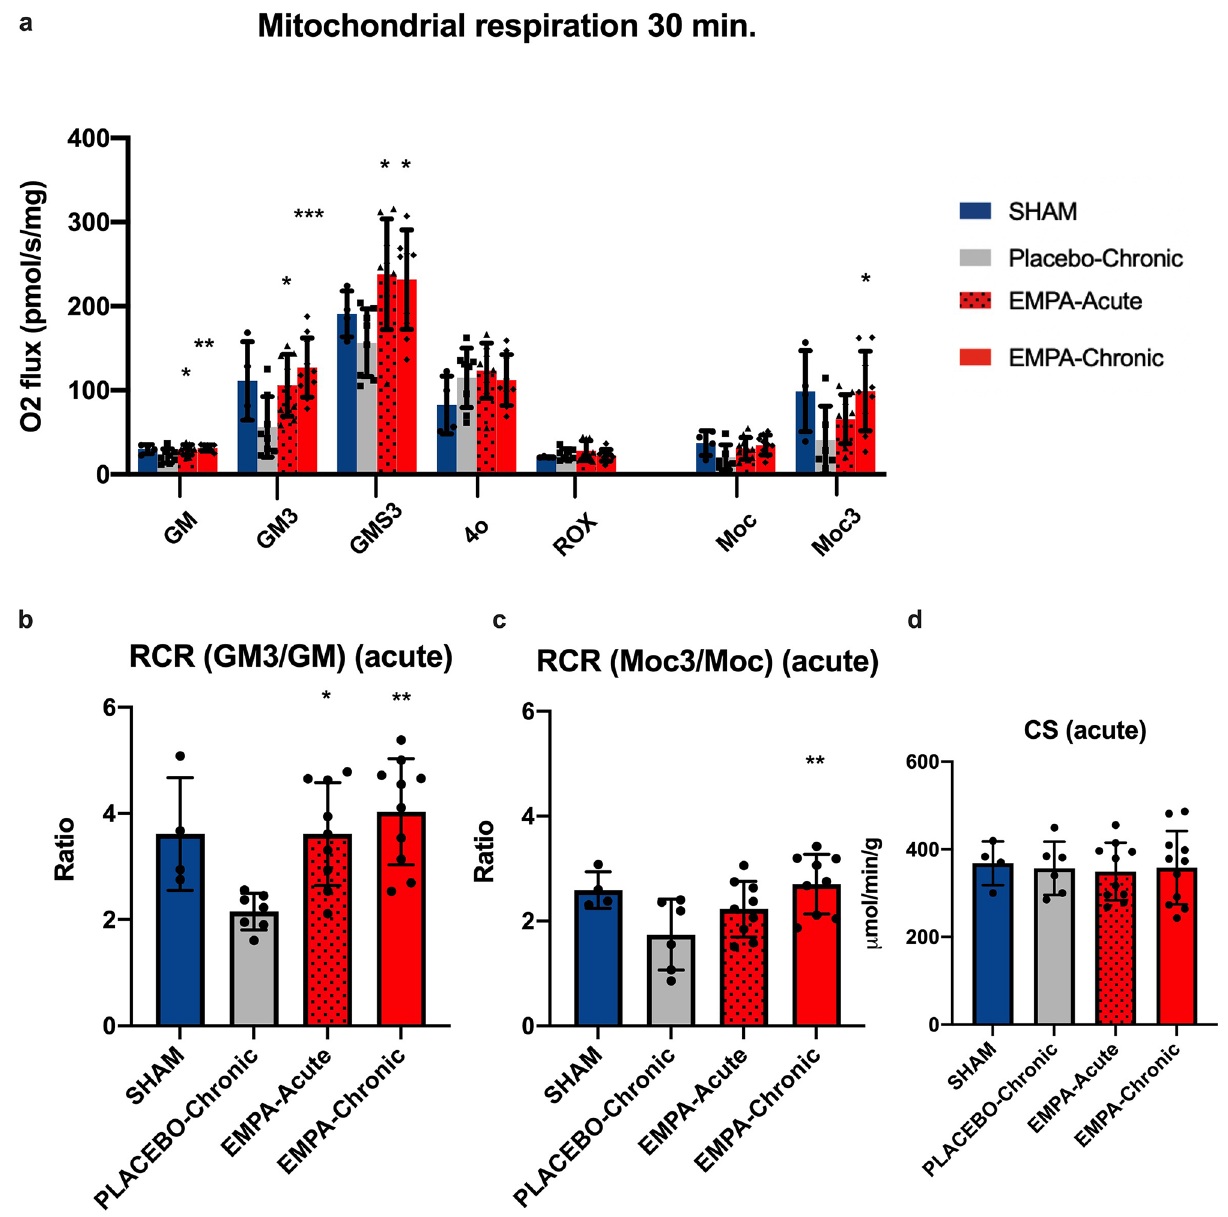
Figure 3. Mitochondrial respiratory capacity in early reperfusion. ( a ) Summarized data of mitochondrial respiration in each respiratory state. ( b ) RCR with complex I linked substrates. ( c ) RCR with complex I + II linked substrates. ( d ) Enzymatic activity of CS. SHAM (n = 4), PLACEBO-Chronic (n = 8), EMPA-Acute (n = 9), EMPA-Chronic (n = 10). GM Complex I respiration with glutamate and malate and ADP, GM3 Complex I respiration with glutamate, malate and ADP, GMS3 Complex I + II respirations with glutamate, malate, succinate and ADP, 4o LEAK/non-phosphorylating respirations with oligomycin, ROX residual oxygen consumption evaluated after adding rotenone and antimycin A, Moc fatty acid respiration with malate and octanoyl-L- carnitine without ADP, Moc3 fatty acid respiration with malate, octanyol-L-carnitine and ADP. RCR respiratory control ratio, CS citrate synthase. Data are mean ± SD. Statistical significance is shown as * p < 0.05, ** p < 0.01, *** p < 0.001 vs. Stimulation of complex I + II yielded an enhanced response in both EMPA-Chronic and EMPA-Acute com- pared to placebo (231.7 ± 59.04 and 238.1 ± 65.77 vs. 156.6 ± 40.25 mol ρ O 2 s -1 mg -1 , p < 0.05). State 4o respiration (non-phosphorylating respiration) and residual oxygen consumption (ROX) were similar between all groups. Respiration with fatty acid substrates 30 min after MI was similar between all groups in complex I (non-ADP stimulated) linked respiration (Fig. 3a). In contrast, EMPA-Chronic increased complex I + II (ADP stimulated) respiration compared to placebo (99.2 ± 47.3 vs 40.8 ± 40.3 mol ρ O 2 s −1 mg −1 , p < 0.05) (Fig. 3a). This was reflected in an increased RCR by EMPA-Chronic (2.7 ± 0.6 vs. 1.7 ± 0.7, p < 0.05) (Fig. 3c).